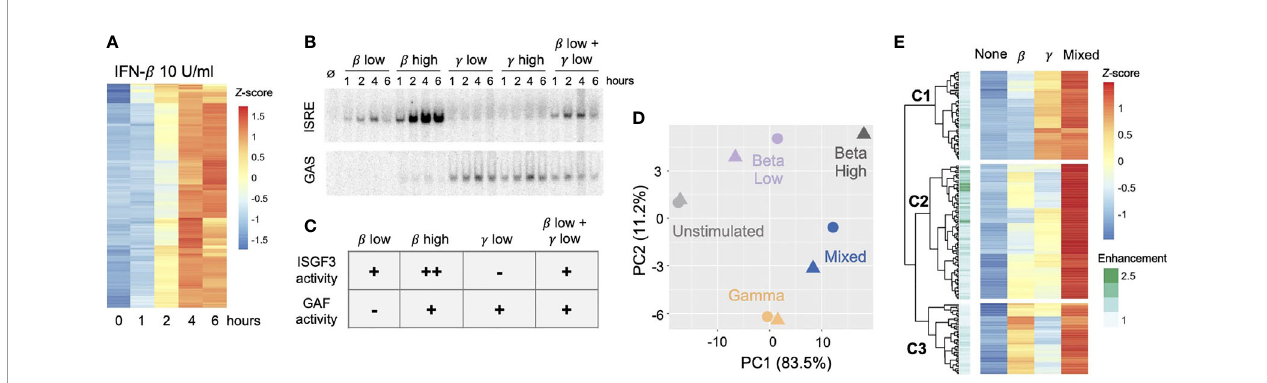
FIGURE 5 | Combined activation of GAF and ISGF3 enhances expression of ISGs In respiratory epithelial cells. (A) Heat map of 179 MLE12 ISGs as de fi ned by induction with 10 U/ml IFN- b using thresholds of FDR<0.5 and fold change>2. (B) EMSA of ISRE and GAS binding in response to IFN- b (1 vs.100 U/mll), IFN- g (1 vs.100 ng/ml), or a mixture of the low doses. Representative gel from fi ve replicates. (C) Table of relative ISGF3 and GAF activation strengths in response to different doses of IFN- b and IFN- g , based on EMSA data. (D) Principal component analysis of ISGs in response to IFN- b low dose (1 U/ml), IFN- g low dose (1 ng/ml), IFN- b + IFN- g low doses ("Mixed"), or IFN- b high dose (10 U/ml). Four-hour stimulation, two replicates. (E) Heat map of ISGs showing response to IFN- b low-dose, IFN- g low dose, and Mixed. First three levels of hierarchical clustering are highlighted. Row annotations indicate Enhancement score, de fi ned as RPKM mixed I (RPKM beta + RPKM gamma